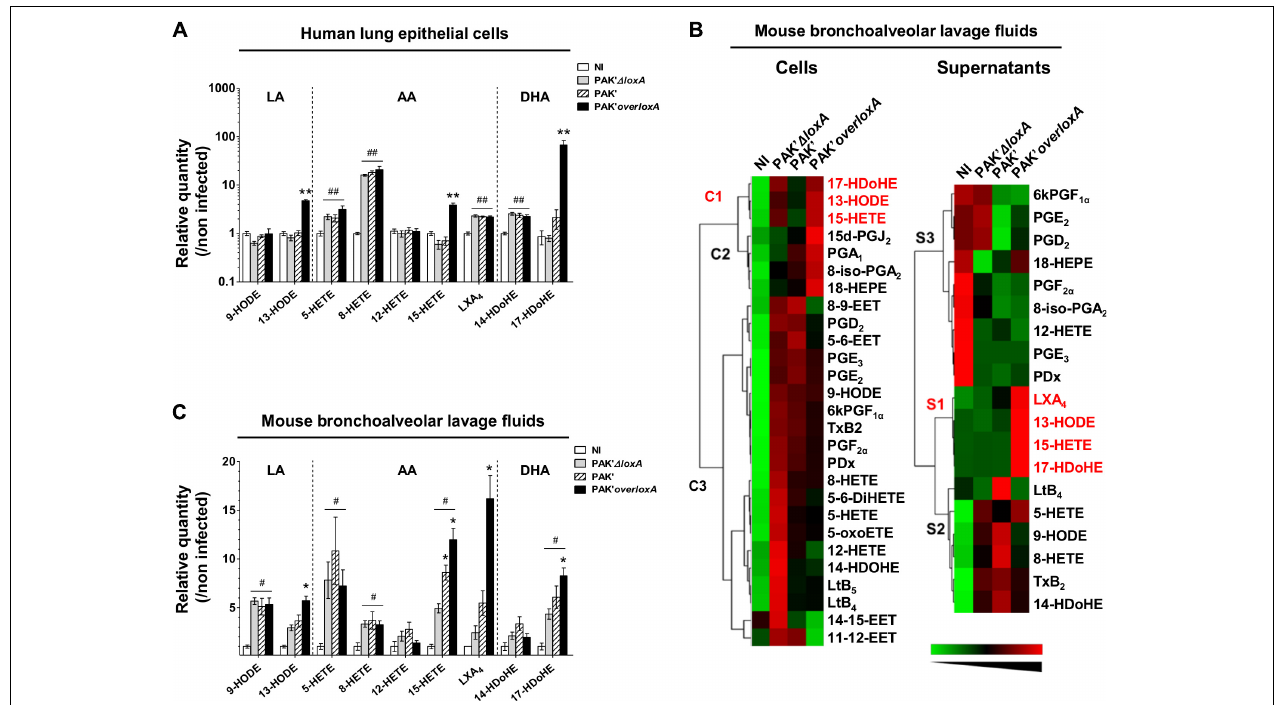
FIGURE 2 | Pseudomonas aeruginosa LoxA secretion increases the production of 15-LOX-dependent metabolites in lung mucosa. (A) Human pulmonary epithelial NCI-H292 cells were infected with exponentially grown PAK’ (cid:49) loxA, PAK’ or PAK’ overloxA strains for 24 h (MOI 0.1). LOX-derived eicosanoids were then measured by LC-MS/MS. For each condition, both cell and supernatant fractions were analyzed and were further pooled for representation. Values are mean ± SEM of fold-induction over non-infected (NI) NCI-H292 cells. Data are representative of three independent experiments. ∗∗ p < 0.01 when one compared PAK’ (cid:49) loxA- with PAK’ overloxA- infected NCI-H292 cells. ## p < 0.01 when one compared PAK’ (cid:49) loxA or PAK’ overloxA vs. non-infected NCI-H292 cells. (B) Heat-maps represent changes in the levels of 28 eicosanoid species in cells and supernatant fractions of BALF collected from PAK’ (cid:49) loxA - or PAK’ overloxA -infected mice relatively to uninfected animals (n = 5–6 mice/group). Increase in metabolite levels are indicated in red , decrease in green , and detectable but unchanged levels in black . Metabolites below the limit of detection are not indicated. The name of 15-LOX-dependent by-products are written along the heat-maps in red. Lipid metabolite clusters in both cellular, and supernatant fractions are also indicated. EET, epoxy-eicosatrienoic acids; HDoHE, hydroxy-docosahexaenoic acid; HEPE, hydrox-eicosapentaenoic acid; HETE, hydroxy-eicosatetraenoic acid; HODE, hydroxy-octadecadienoic acid; Lt, leukotriene; LX, lipoxin; oxoETE, oxo-eicosatraenoic acid; PD, protectin; PG, prostaglandin; Tx, thromboxane. (C) Quantitative analysis of LOX-dependent metabolites. Balb/c mice were intranasally instilled with exponentially grown PAK’ (cid:49) loxA or overloxA strains for 24 h (0.5–1.10 8 cfu/mice). At 24 h post-infection, LOX-derived eicosanoids in BALF were measured by LC-MS/MS. For each condition, both cell and supernatant fractions were analyzed and were further pooled for representation. Values are mean ± SEM of fold-induction over non-infected (NI) animals ( n = 5–7 mice/group). ∗ p < 0.05 , ∗∗ p < 0.01 when one compared PAK’ (cid:49) loxA- with PAK’ or PAK’ overloxA- infected mice. # p < 0.05 , ## p < 0.01 when one compared PAK’ (cid:49) loxA or PAK’ overloxA vs. non-infected animals. Data are representative of three independent experiments. All absolute quantification values are available in Supplementary Tables S1 , S2